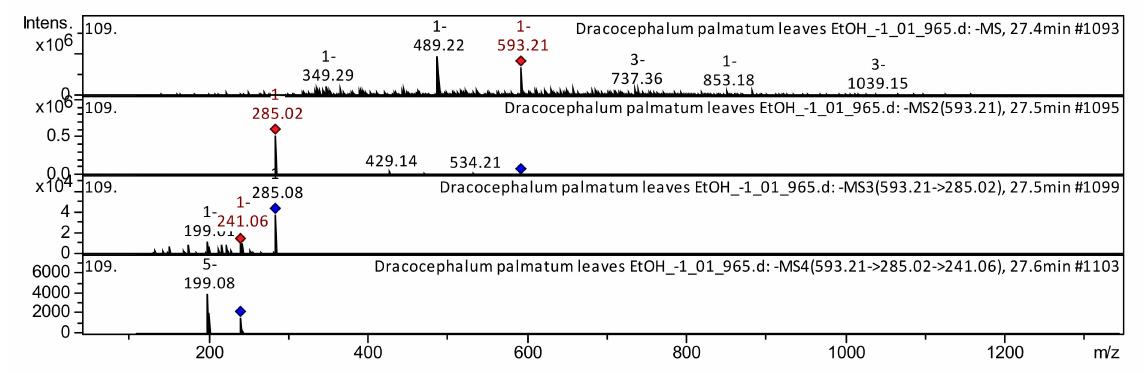
Figure 7. CID spectrum of kaempferol 3- O -rutinoside from extracts of D. palmatum , m / z 593.21.